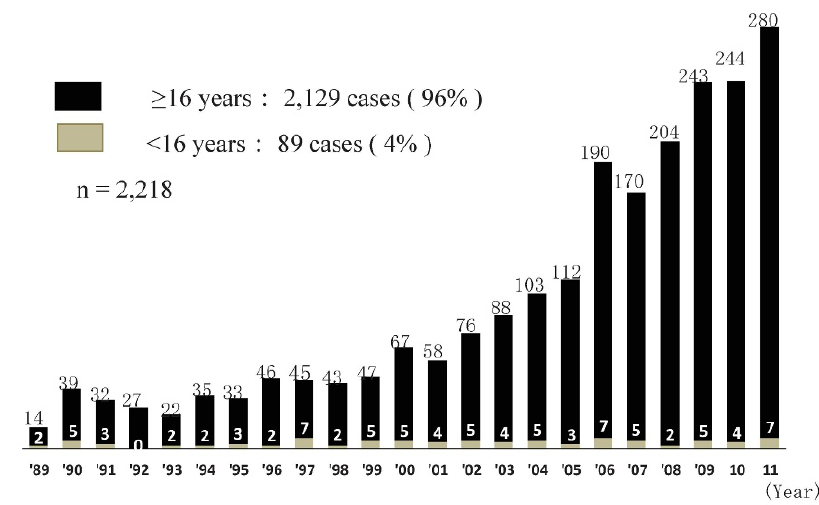
Figure 1 - Annual Number of ABO-Incompatible Kidney Transplantations in